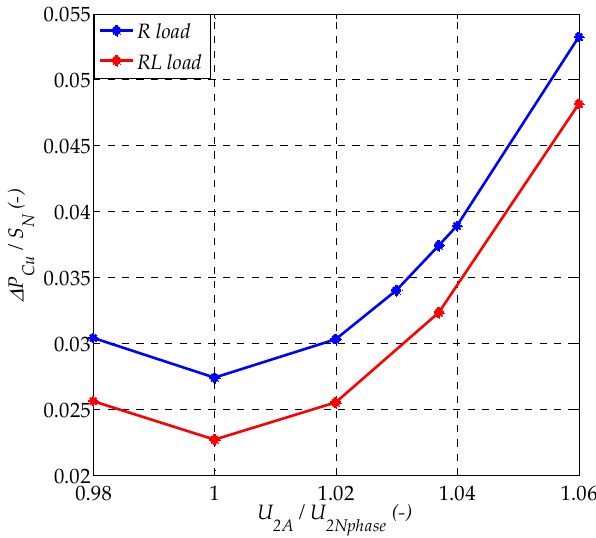
Figure 11. Load losses of the transformer with amplitude control as a function of this amplitude value, at φ 2A = 0.